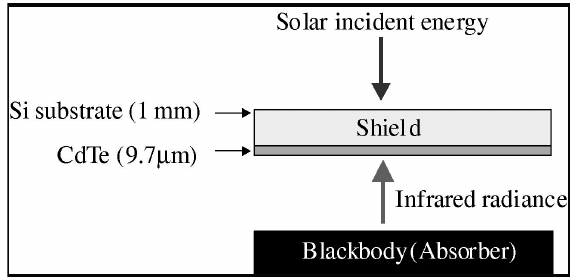
Figure 27. Schematic diagram of convective shielding to improve performance [152]. In a comparison of 30 potential thin-film PRC materials (a combination of 16 different thin-film materials) for passive cooling applications, Naghshine et al. [154] concluded that structures with cubic ZnS multilayers (see Figure 28a) effectively shielded the PRC emitter from parasitic heating loss leaking in both during the day and at